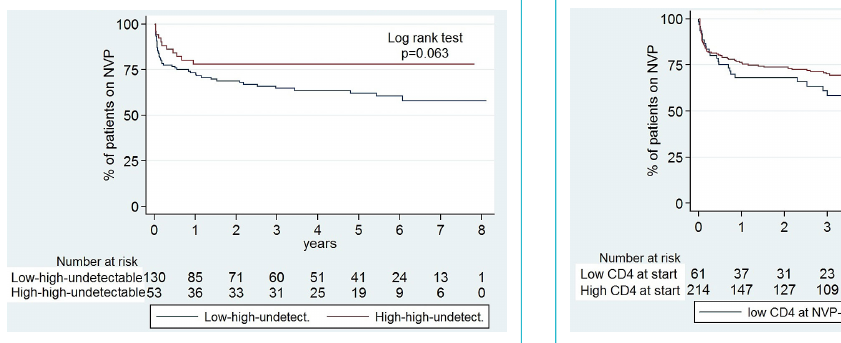
Figure 3: Kaplan-Meier survival curves: probability of remaining on nevirapine (NVP) with high CD4 at NVP start versus low CD4 at NVP start.